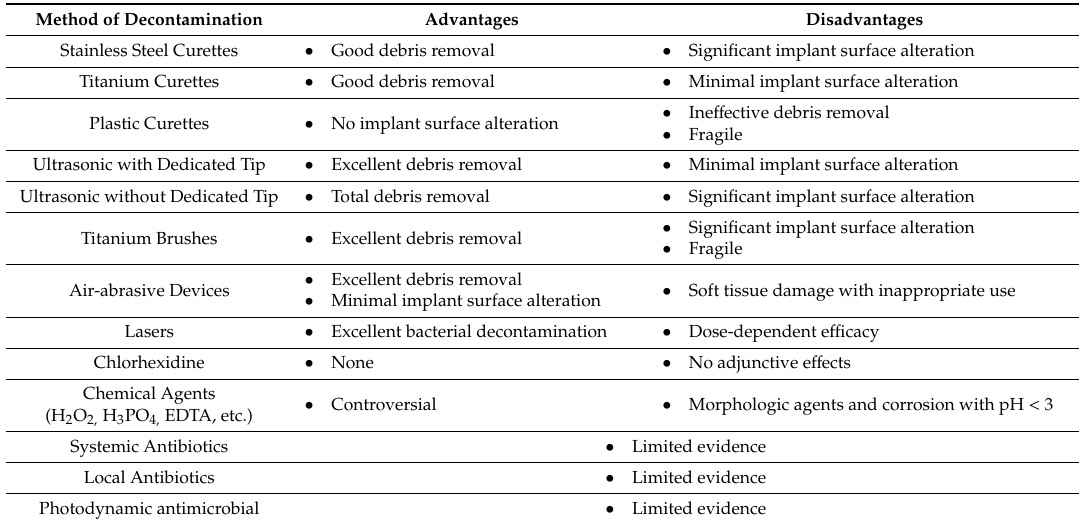
Table 3. Methods, techniques, adjunctive and antimicrobial agents for implant surface decontamination. Method of